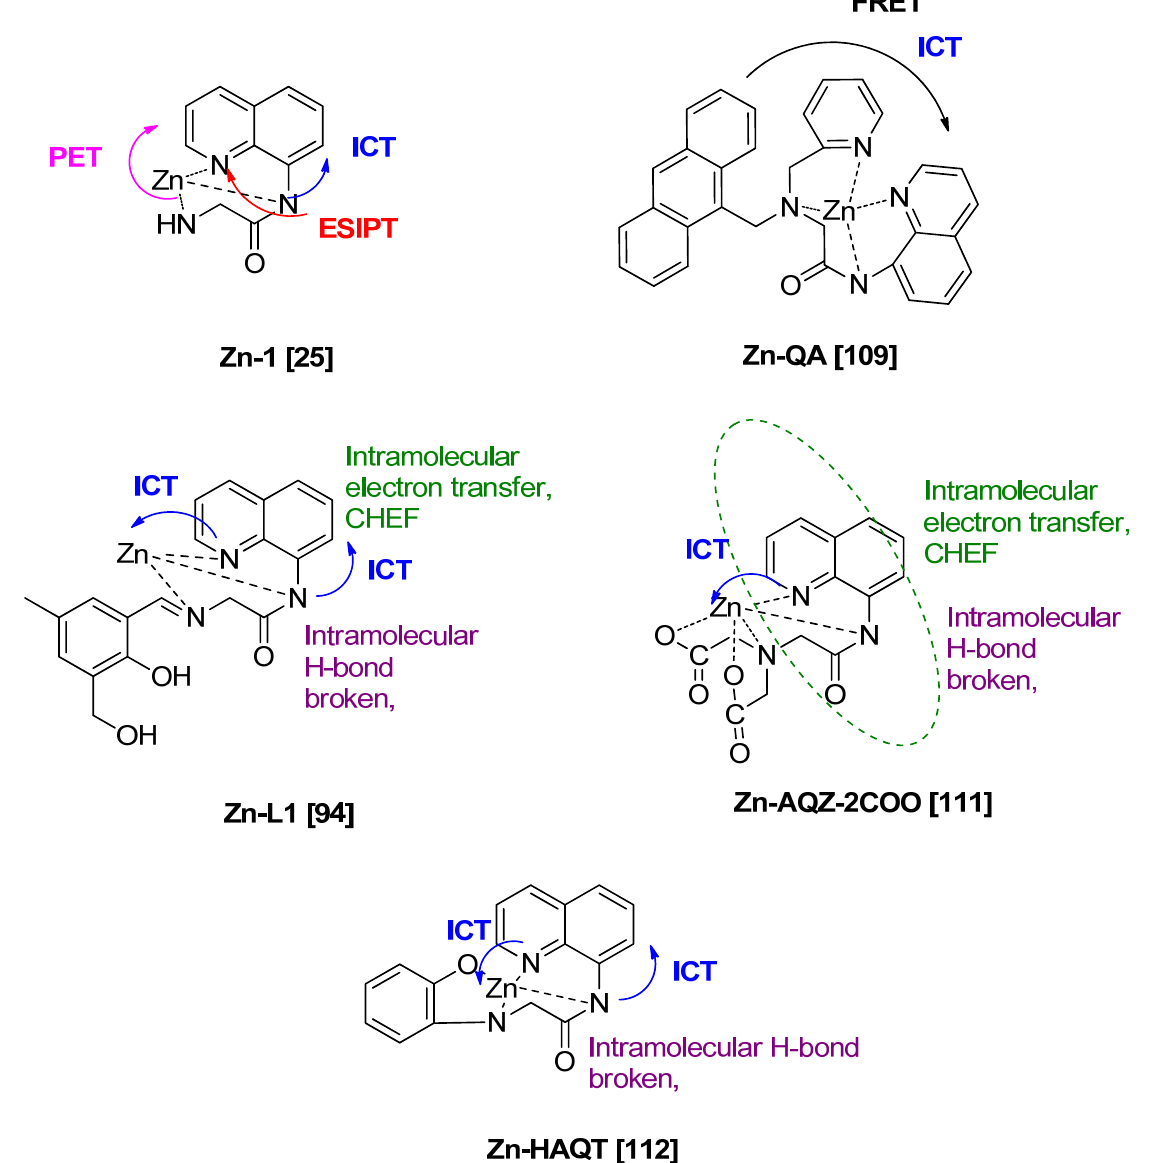
Figure 11. Possible mechanisms and interactions involved 8-amidoquinoline derivatives upon binding with Zn 2+.